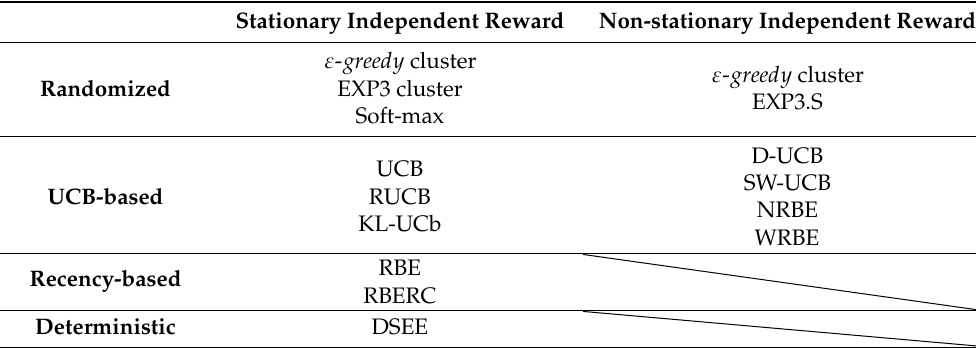
Table 1. The summary of policies for MAB